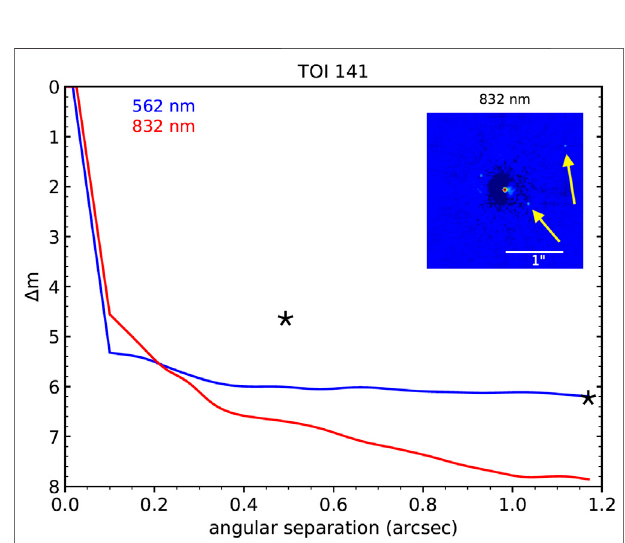
FIGURE7| Oneofourstandardpipelinereduceddataproducts.Theplot shows our 5 σ contrast curves in both fi lters as a function of the angular separationoutto1.2 arcsec,theendofspecklecoherence.Inaddition,theinset shows the reconstructed 832 nm image with a 1 arcsec scale bar. This star, TOI 141, was found tohave two close companions, one at 0.5 arcsec (PA (cid:2) 240 degrees, Delta magnitude (cid:2) 4.6) and one at 1.3 arcsec (PA (cid:2) 307 degrees,Deltamagnitude (cid:2) 6.2).Theyellowarrowsmarkthecompanionsinthe reconstructed image and the black stars mark the locations of the stars on the main plot, the 1.3 arcsec companion placed at 1.2 ″ to fi t within the